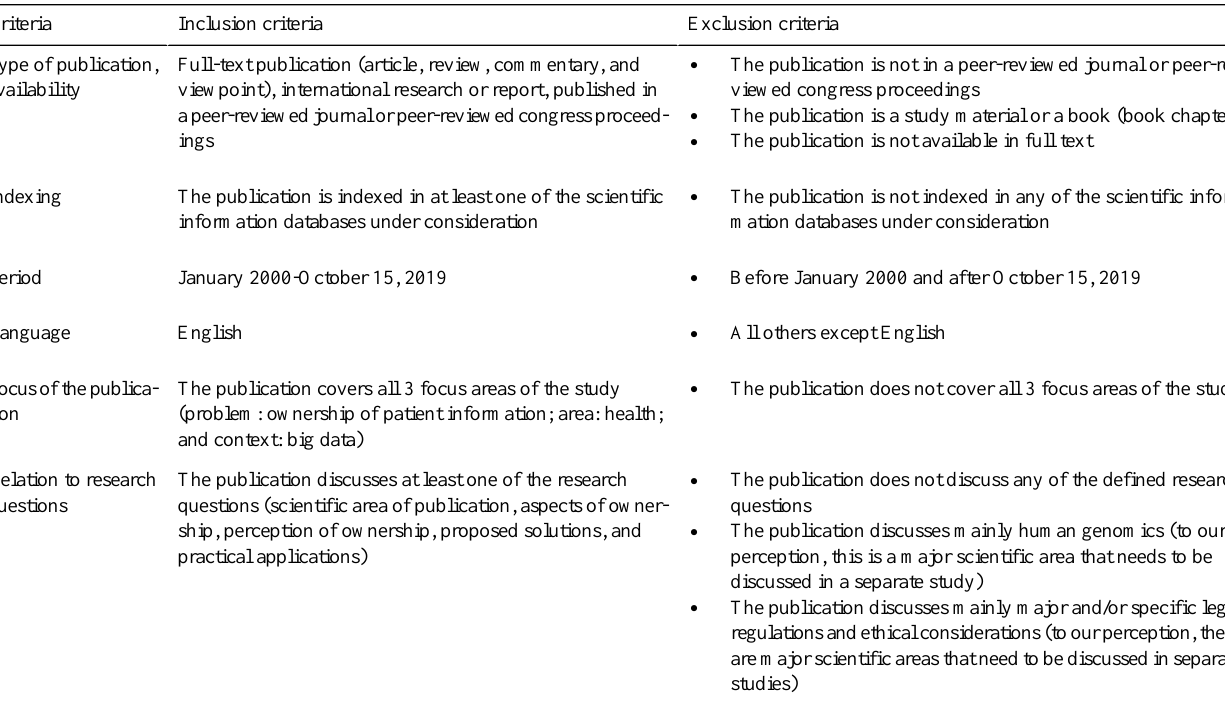
Table 1. Eligibility criteria for inclusion and exclusion of publications in the